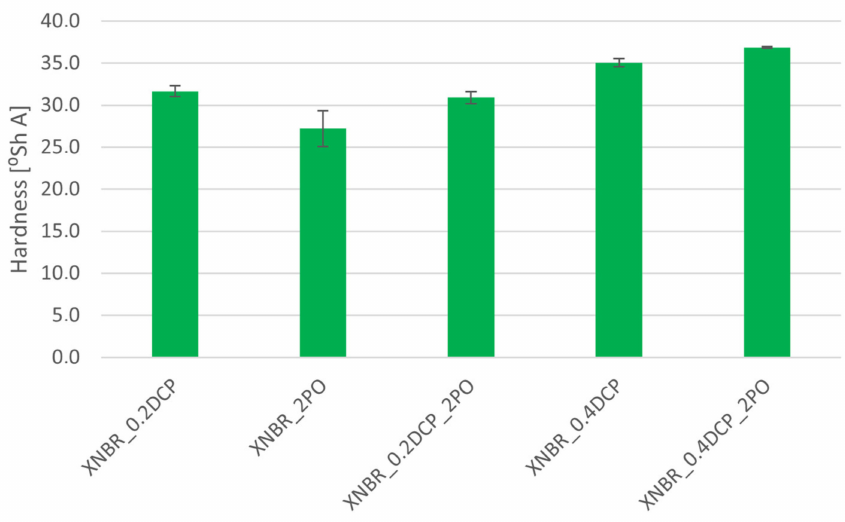
Figure 13. Influence of peroxide curing system modification on hardness of XNBR